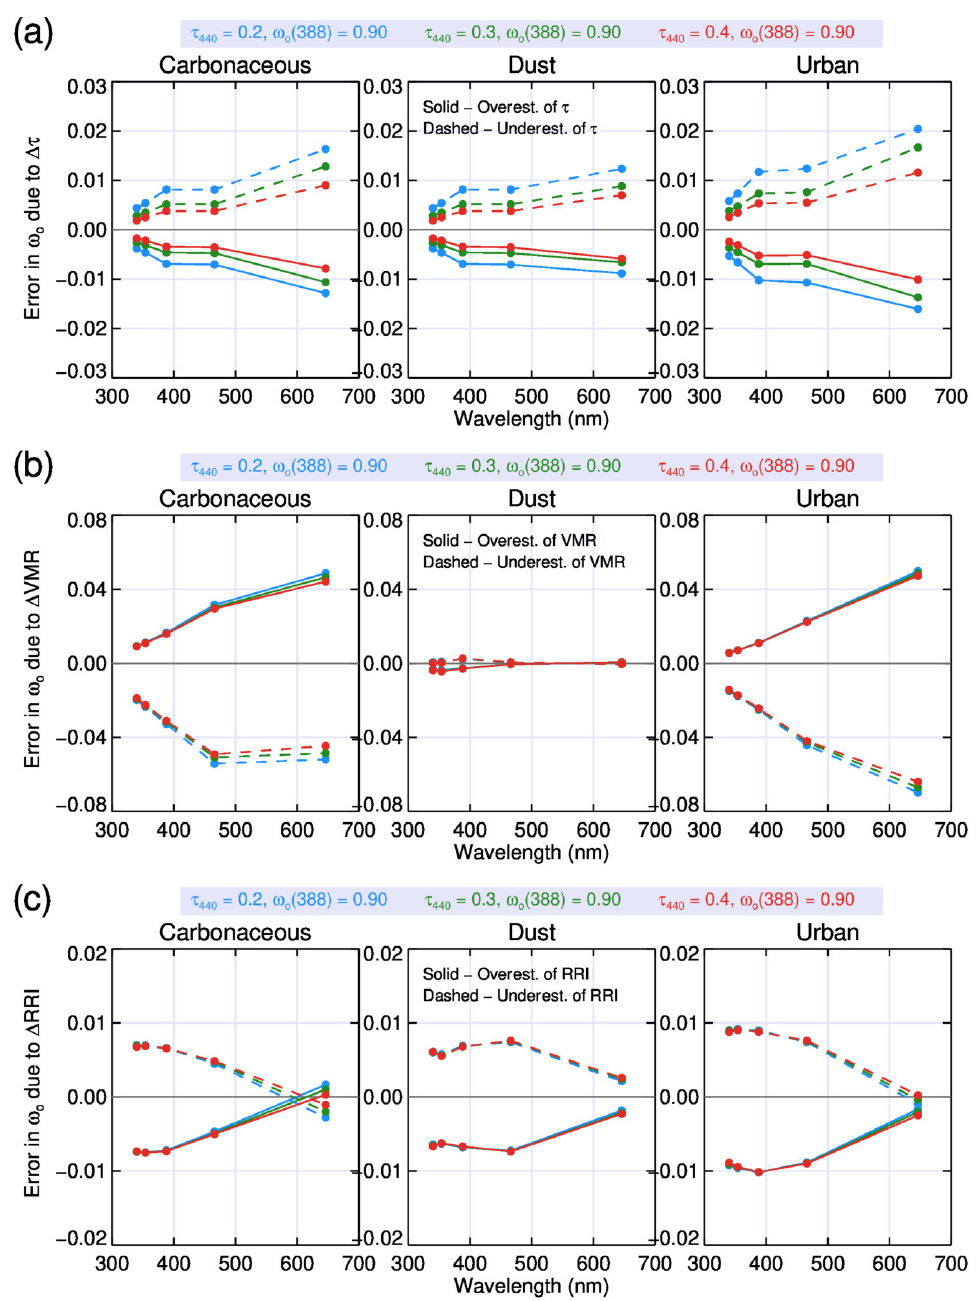
Figure 5. Theoretical uncertainty in SSA retrievals due to changes in (a) ± 0 . 02 ( λ < 400nm) and ± 0 . 01 ( λ > 400nm) τ , (b) ± 20% volume mean radius (VMR), and (c) ± 0 . 04 real part of the refractive index (RRI). Solid and dashed lines represent the overestimation and underestimation of the corresponding input